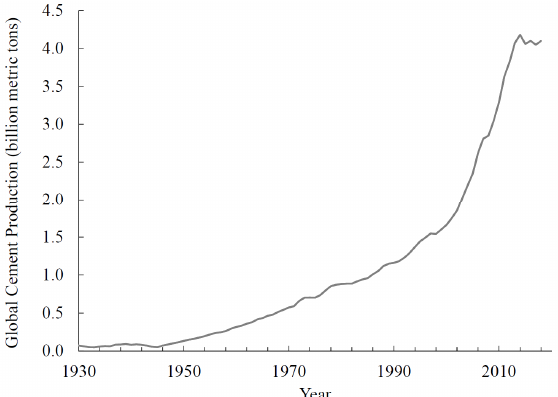
Figure 10. Global cement production from 1930 to 2018. In 2018 the United States produced 85.4 million tonnes of Portland cement and 2.4 million tonnes of masonry cement. Data are from U.S. Geological Survey [44 ‐